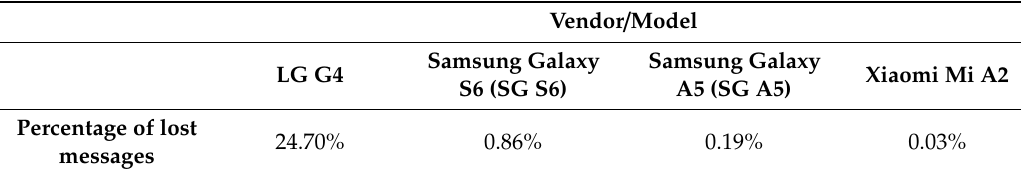
Table 2. Percentage of lost measurements for a sampling rate of 100 Hz and when just one sensing node is integrated in the